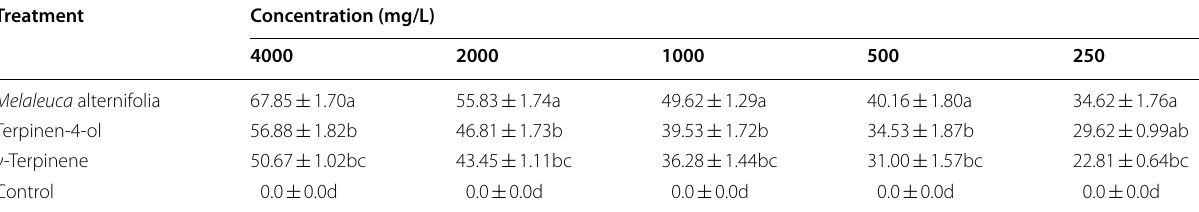
Means SE within the same column having the same letter are not statistically different from each other, P ± replicates of 10 larvae